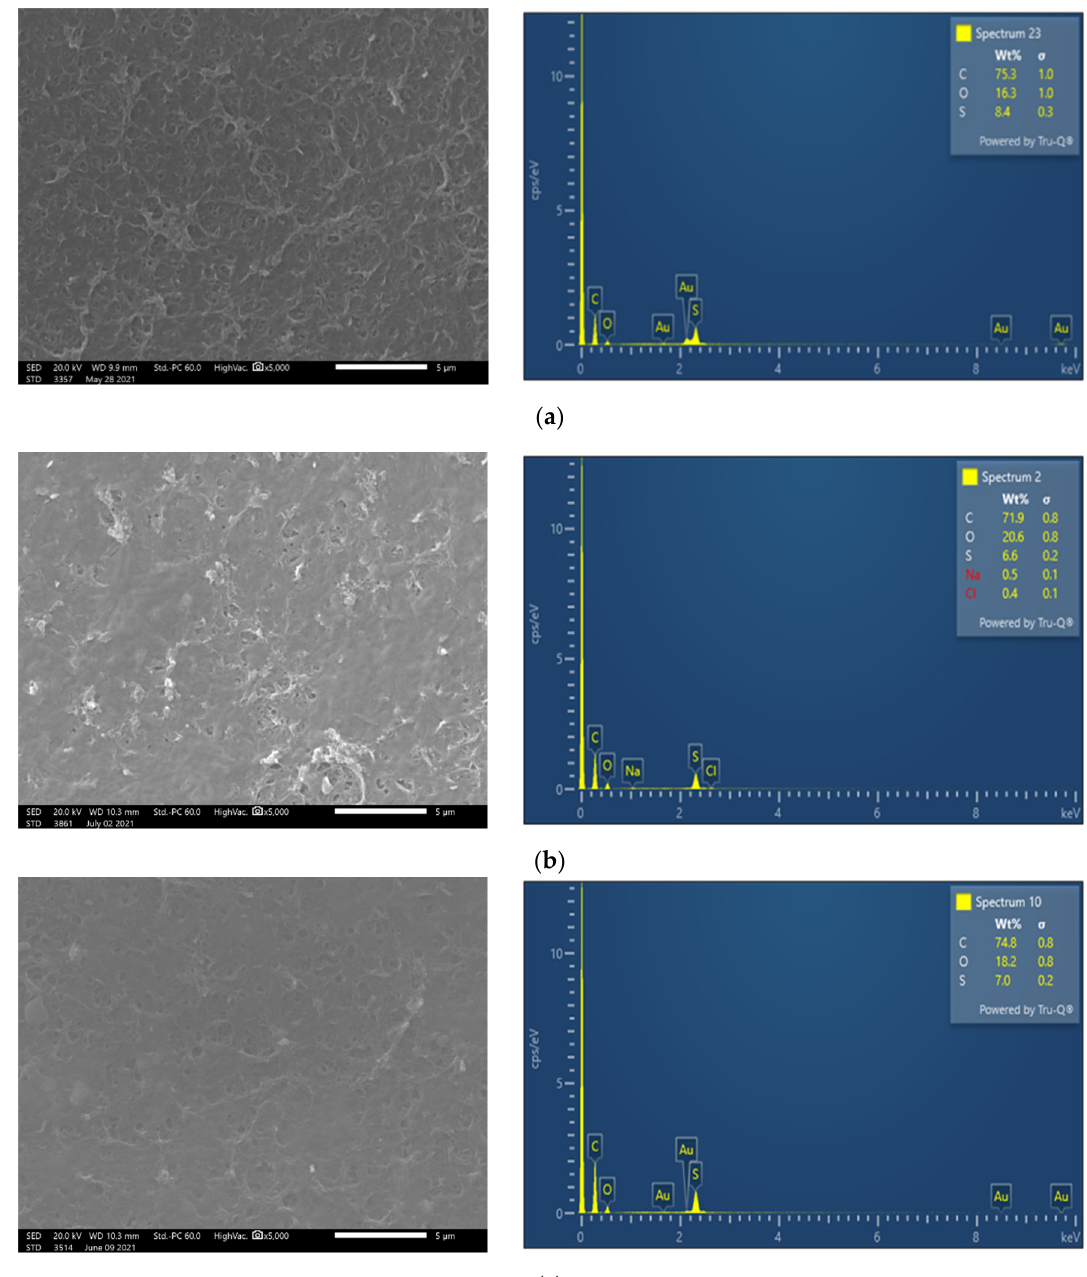
ND: Not detected/insignificant; * NF90 membrane from the first test section right after the test; ** NF90 membrane from the second test section after the test and flushing of the experimental set-up with deionized water.